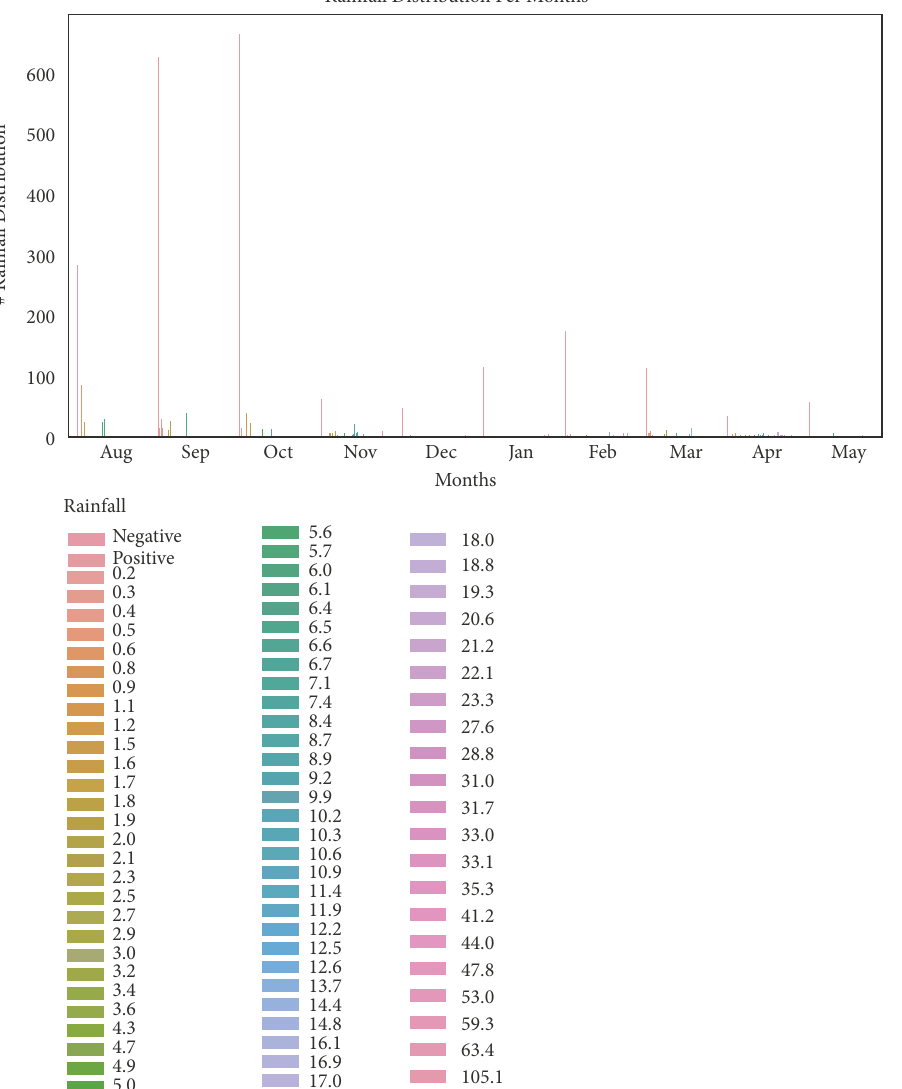
Figure 3: Rainfall distribution per